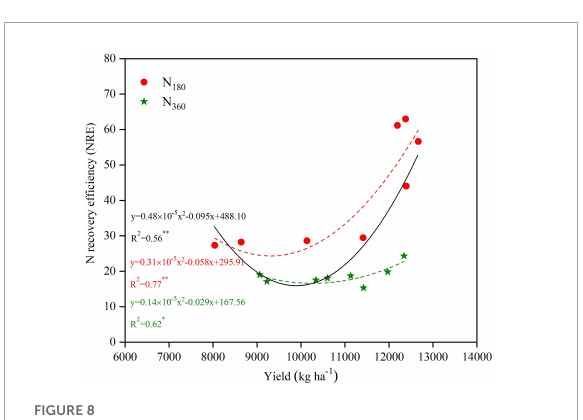
FIGURE9 Relationships between yield and internal N use efficiency (IE N ) for maize in 2019 and 2020. Linear regressions were fitted for the low yield data ( < 10,000 kg ha – 1 ; black solid line) and high yield data ( ≥ 10,000 kg ha – 1 ; orange solid line). Non-linear regressions were fitted for the data under the N 0 inputs (blue dashed line), N 180 inputs (red dashed line), and N 360 inputs (green dashed